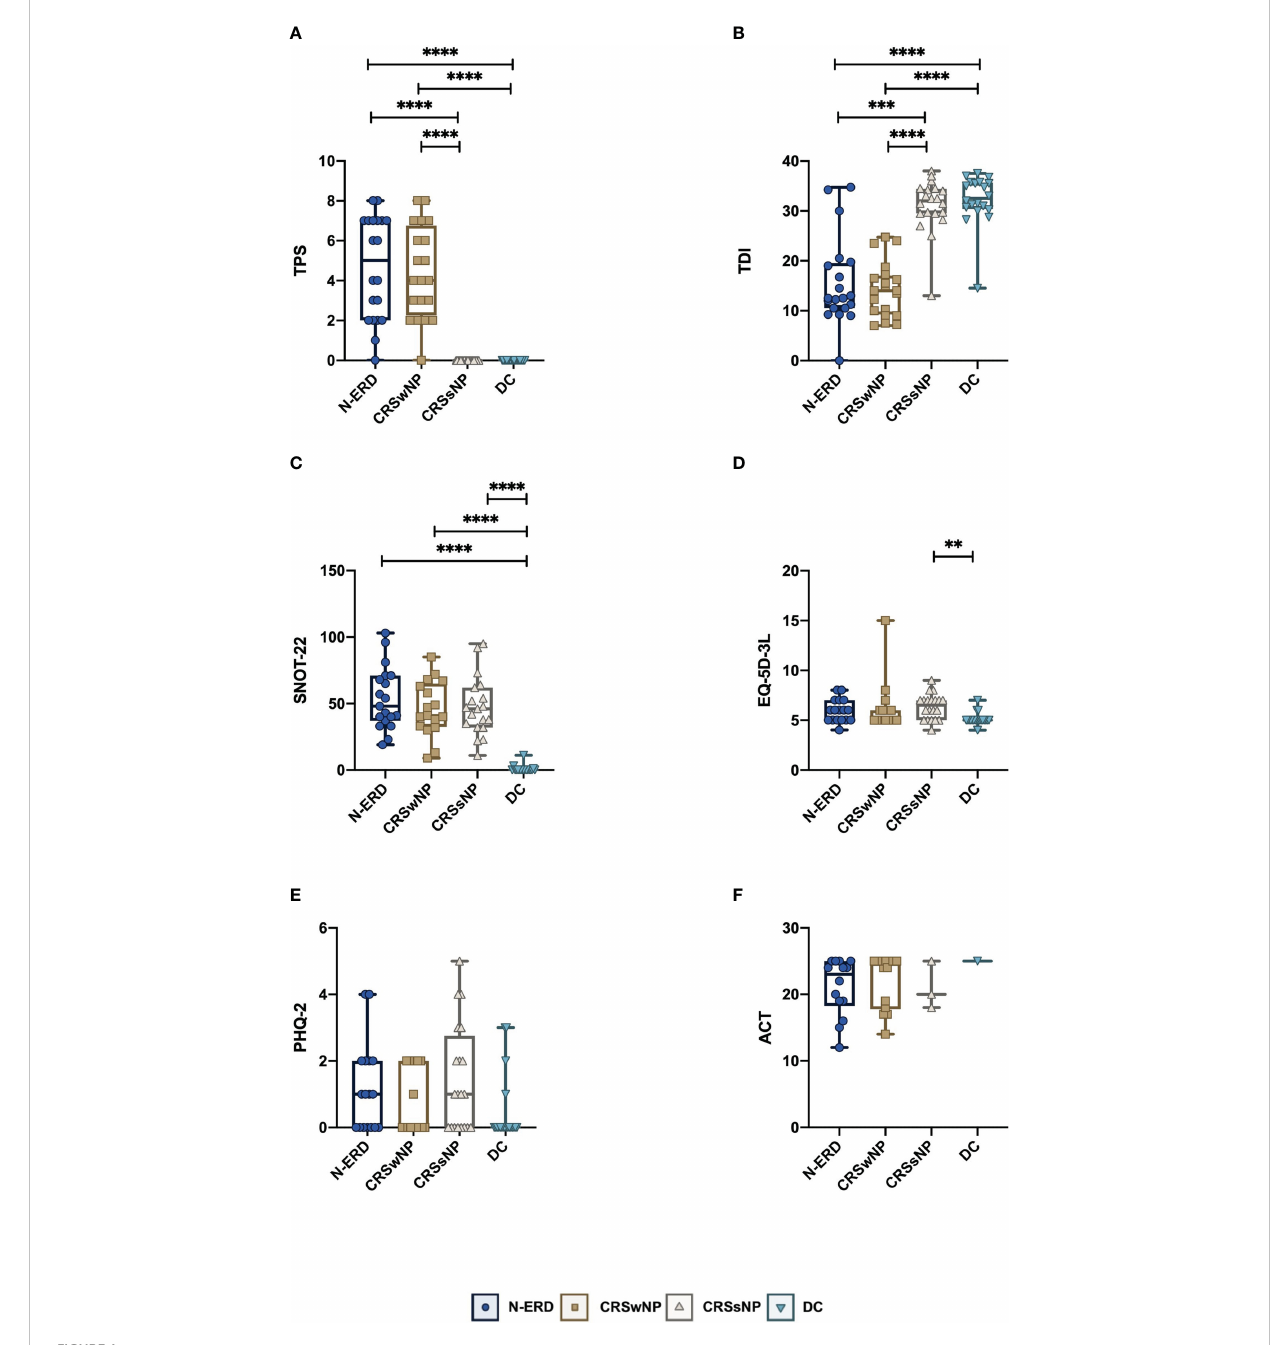
FIGURE 1 Clinical characteristics of patients suffering from chronic rhinosinusitis with (CRSwNP), without nasal polyposis (CRSsNP), non-steroidal anti- in fl ammatory drug-exacerbated respiratory disease (N-ERD) as compared to disease controls (DC). (A – F) Plots display values of (A) total polyp score (TPS), (B) threshold discrimination and identi fi cation score (TDI), (C) sinonasal-outcome test 22 (SNOT-22), (D) European Quality of Life 5 Dimensions 3 Level Version (EQ-5D-3L), (E) Patient Health Questionnaire-2 (PHQ-2) and (F) asthma control test (ACT) score in patients with CRSsNP (grey triangles, n=20 for all graphs except ACT: n=3), CRSwNP (brown squares, n=20 for all graphs except ACT: n=14) or N-ERD (dark blue circles, n=20 for all graphs except ACT: n=14) as compared to disease controls (DC, light blue triangles, n=20 for all graphs except ACT: n=1). Stars represent statistically signi fi cant differences between groups; using Kruskal-Wallis test (Table E3) followed by Dunn ’ s test (**P ≤ 0.01, ***P ≤ 0.001, ****P ≤ 0.0001). Line within each box represents the median, bottom border represents the 25 th percentile and top border the 75 th percentile of the data. Whiskers extend 1.5 times the interquartile range and diamond shaped points are